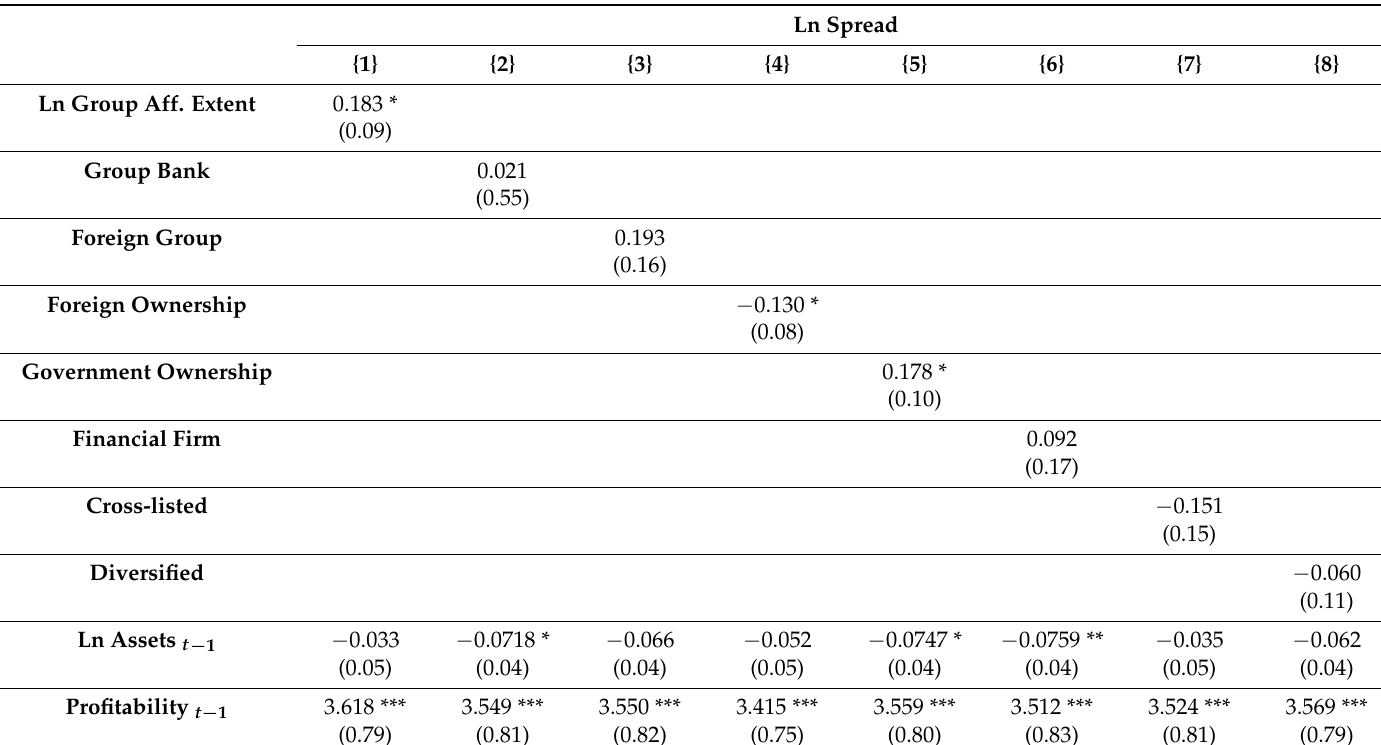
Table 4. OLS regressions of spread on Group Affiliation Extent, Group Bank, Foreign Group, Foreign Ownership, Government Ownership, Financial Firm, Cross-listed, Diversified, and Borrower and Loan Characteristics. Table 4 presents the pooled ordinary least squares (OLS) regression results of ln (Spread) on Group Affiliation Extent, Group Bank, Foreign Group, Foreign Ownership, Government Ownership, Financial Firm, Cross-listed, Diversified, and Borrower and Loan Characteristics. Group Affiliation Extent is calculated based on the percentage of group ownership in borrower firms (0% indicates that there is no group association, and 100% means that the associated group owns all the firm’s shares). Binary variables indicate whether a Group Bank, Foreign Ownership, Government Ownership, or Foreign Group Affiliation exist, whether the borrower is Focused or Diversified, whether it is a Financial Firm, and whether it is Cross-listed. Control variables include firm and loan characteristics, and loan type, year and industry dummies. Robust standard errors are reported in parentheses. Each model is clustered at the group level to control for possible group fixed effects. *, **, and *** represent significance levels of 10%, 5%, and 1%